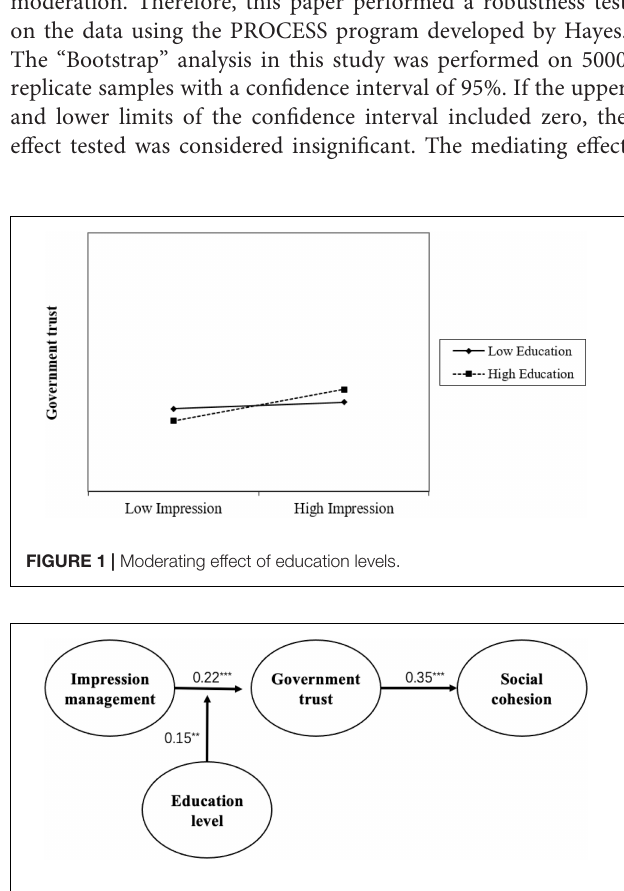
FIGURE 2 | Model path coefficient diagram.